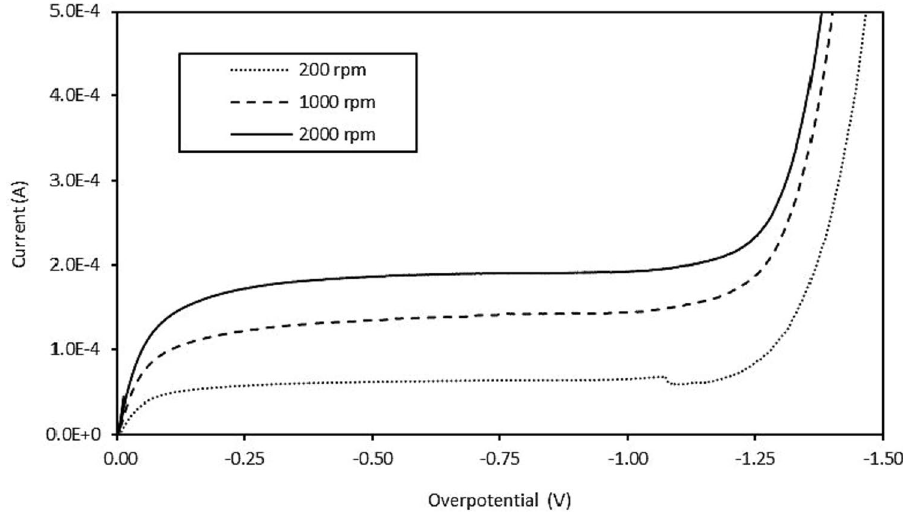
Fig. 13 IV curve for electrode of